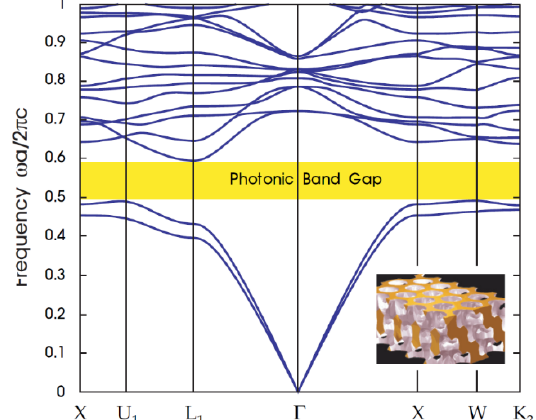
Figure 14. Representation of the photonic band gap sample (yellow colored area) on the photonic band diagram. The different directions along the crystal lattice indicated by the letters along the x-axis [144] (Reprinted with permission from Creative Commons Attribution-NonCommercial-ShareAlike 3.0 license.). Photonic crystals (PCs) are materials that are periodically distributed in one, two or three spatial directions, showing stop bands or photonic band gaps (PBGs) [141,145]. The EMWs cannot propagate through the structure, with frequencies falling within